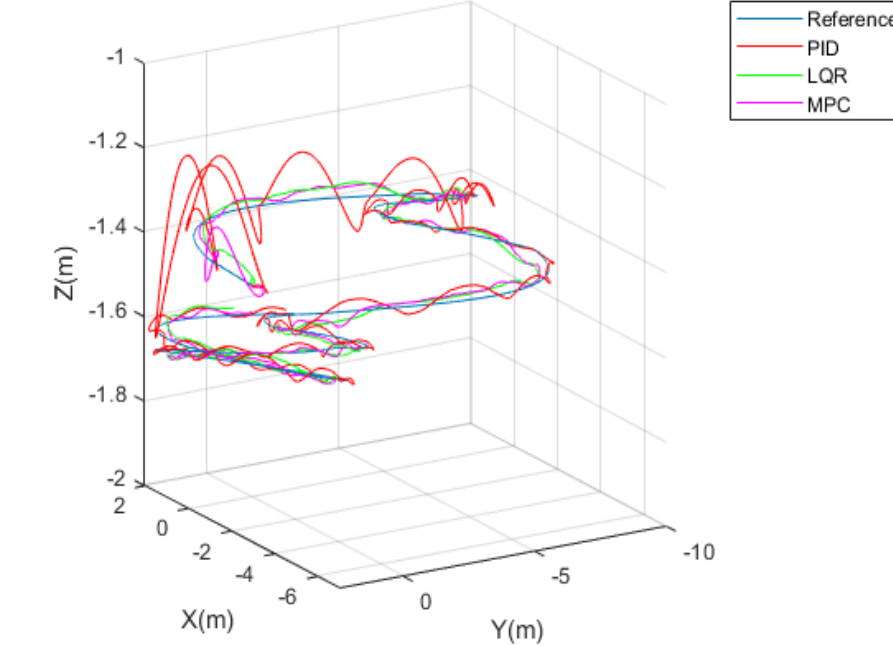
Figure 3. Tracking performances of PID, LQR and MPC during simulation.